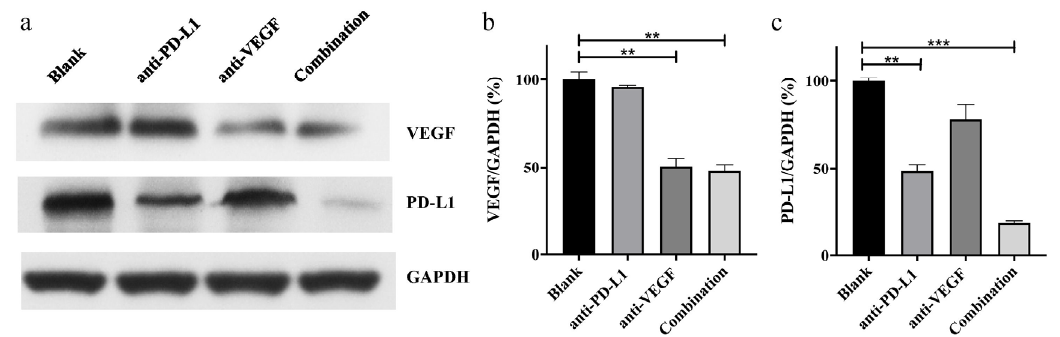
Figure 11. In vivo gene silencing efficiency of VEGF and PD-L1. ( a ) Western blotting was used to indicate the expression of VEGF and PD-L1. The expression of VEGF ( b ) and PD-L1 ( c ) was quantitatively analyzed by Image J. Data are shown as the mean ± S.D. (n = 4, ** p < 0.01, *** p < 0.001).